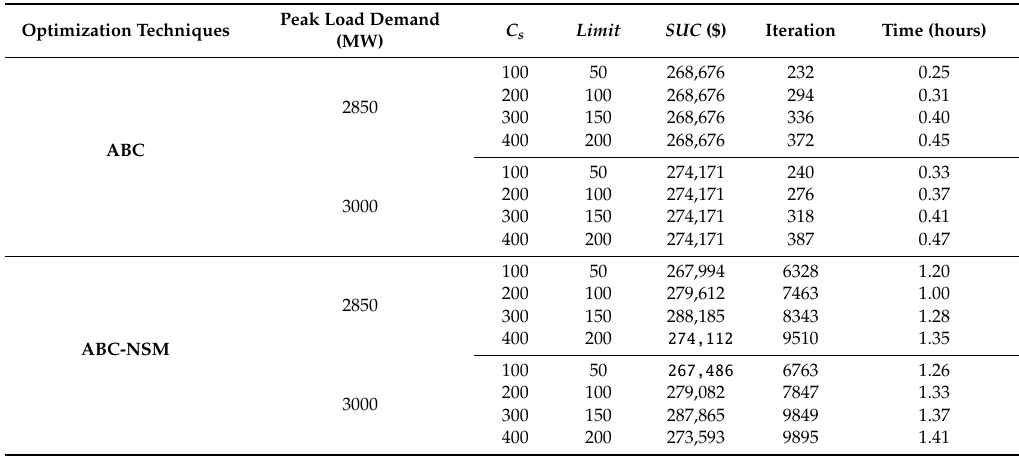
Table 2. Results of saving utility cost ( SUC ) based on di ff erent selected values of Cs and its computational time for every optimal solution performed by Artificial Bee Colony (ABC) and MABC-NSM techniques for peak load demands of 2850 MW and 3000